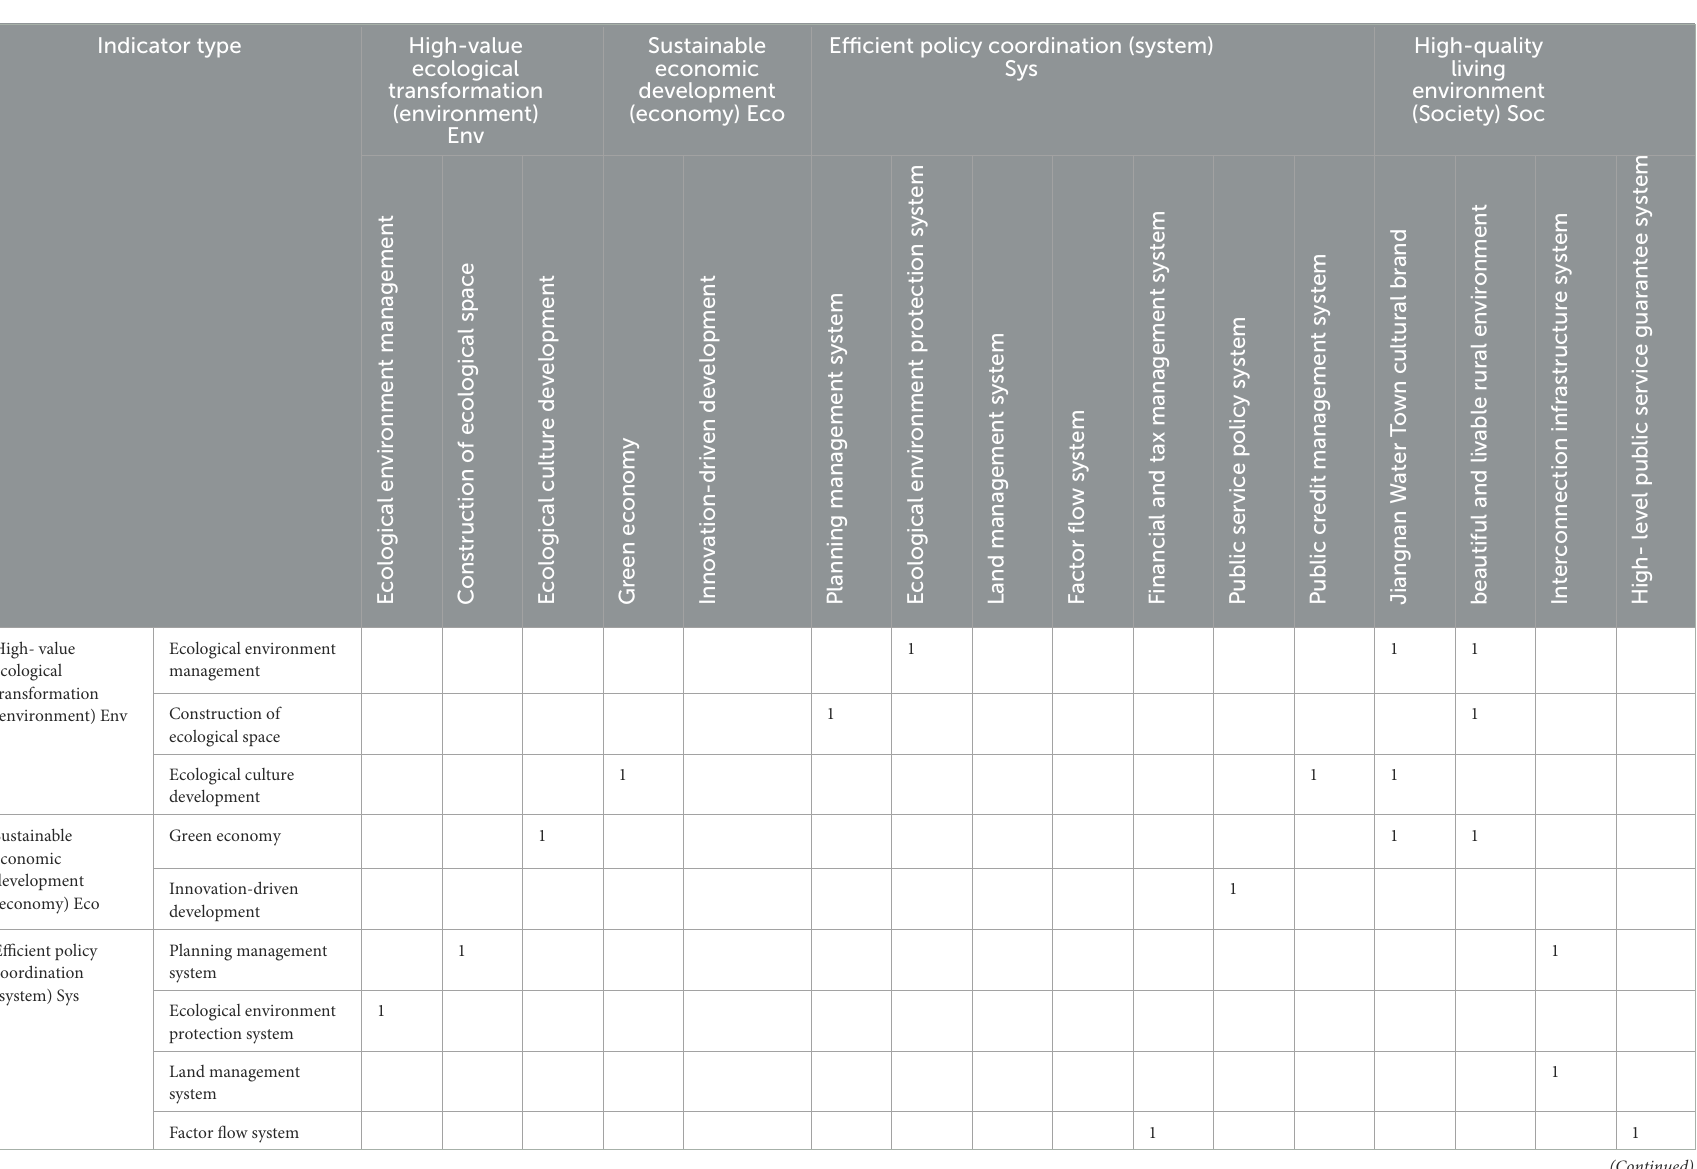
TABLE 2 Correlation matrix between